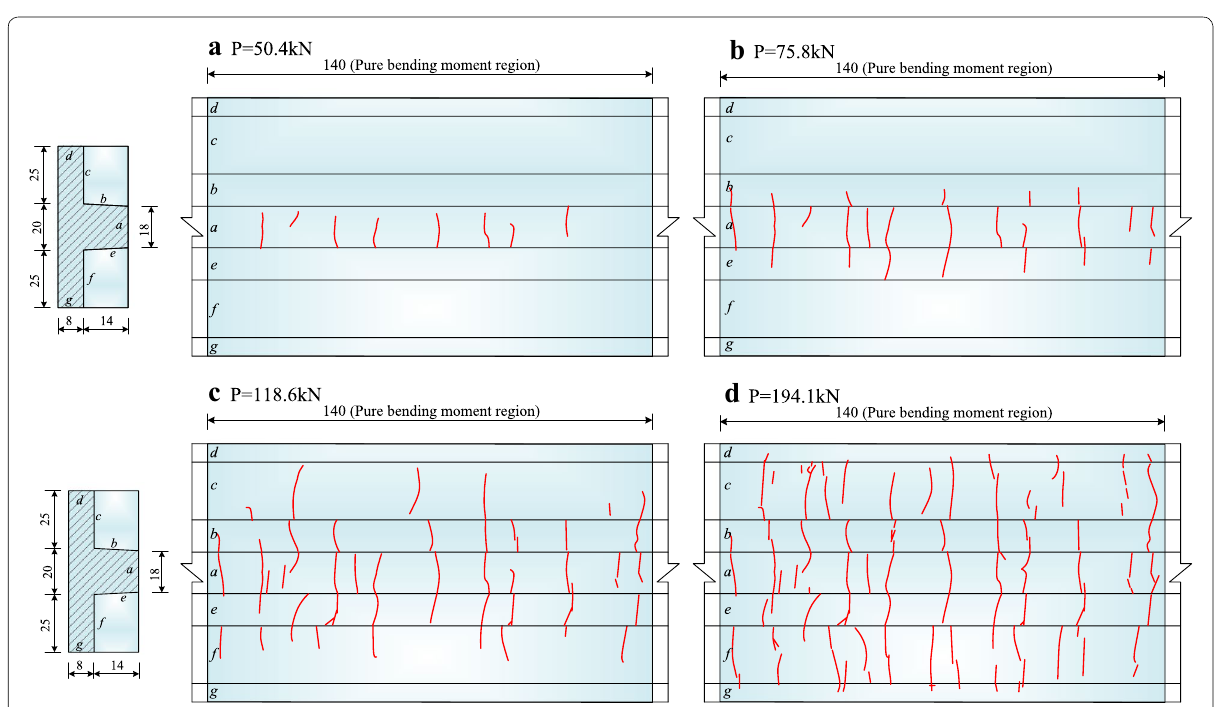
Fig. 15 Crack patterns of B-S65-20 at various stages (unit: